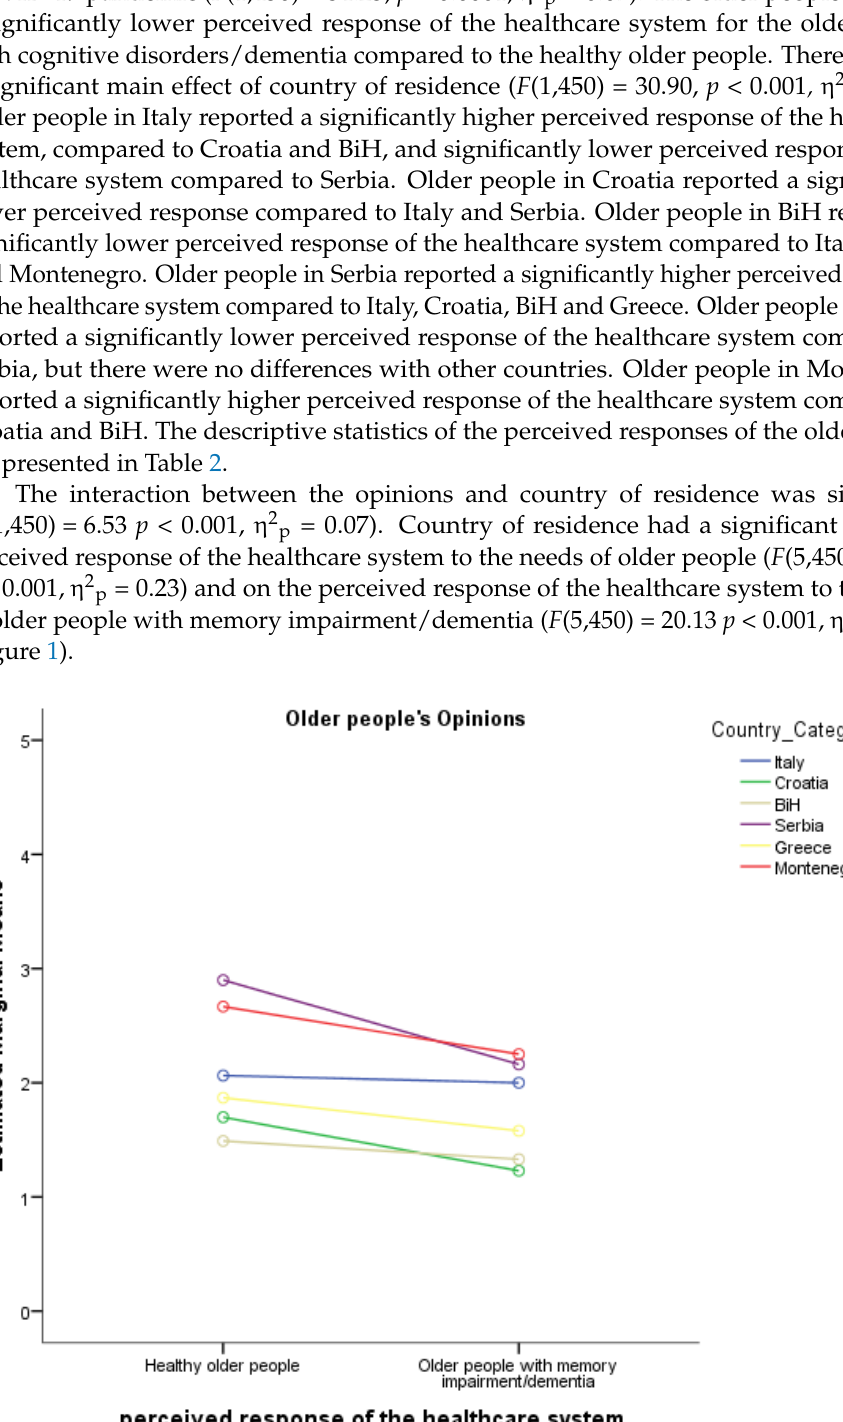
Figure 1. Simple effects from the interaction between the opinions of perceived response of the healthcare system and the country of residence.